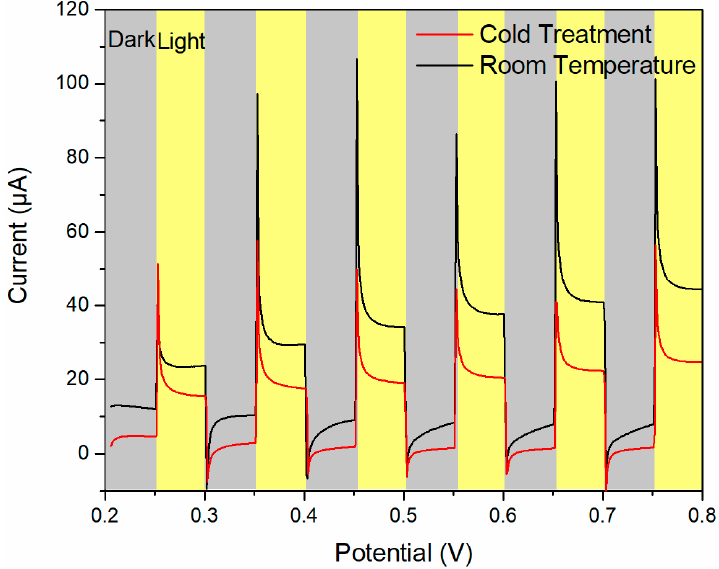
Figure 6. Amperometric I–t curves of the the light-hematite-PAO1 system with different conditions under light on/off cycles.